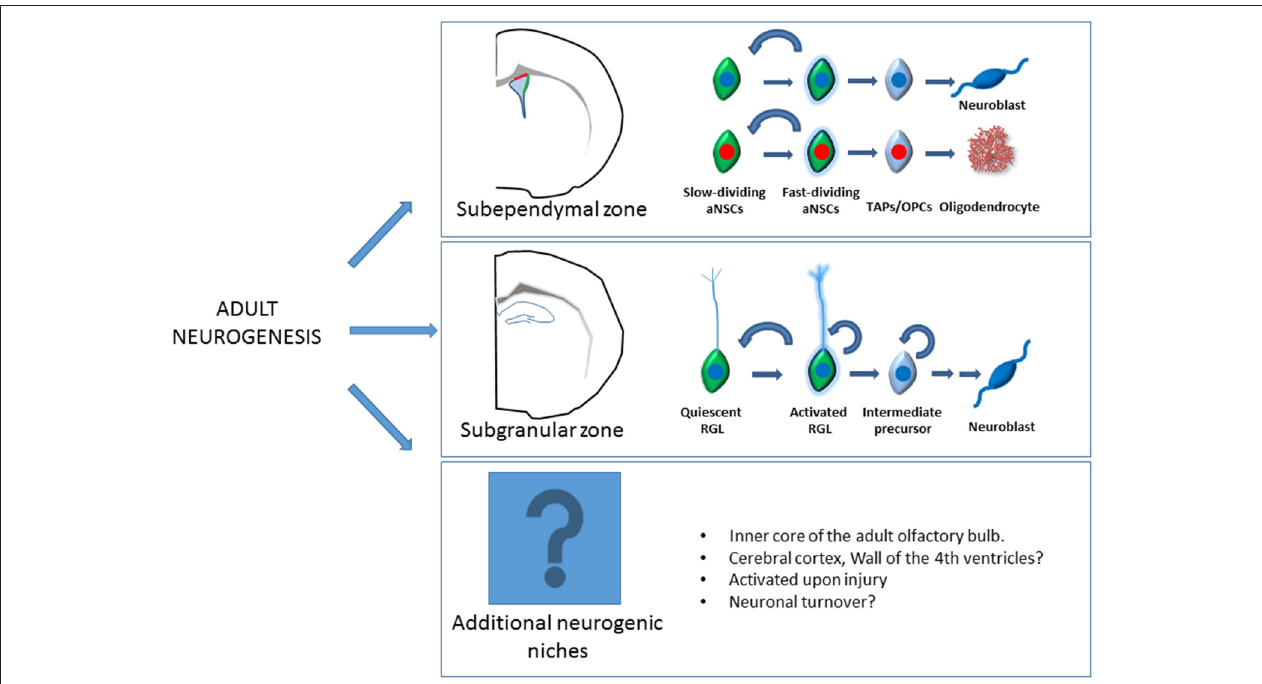
FIGURE 1 | Schematic representation of the adult neurogenesis. Here there are depicted the two main adult neurogenic niches, the subependymal zone in the lateral wall of the lateral ventricle and the subgranular zone in the hippocampus. Live imaging experiments have shown than within the SEZ, neurogenic, and oligodendrogliogenic lineage follows a similar pattern of lineage progression but constitutes independent lineages. Slow dividing astroglia (quiescent type B cells) give rise to fast dividing astroglia (activated type B cells) that subsequently generates Transit amplifying progenitors (TAPs) and finally neuroblast or oligodendrocytes. In the SGZ, quiescent radial glia like (RGL) progenitors become activated giving rise to intermediate progenitors and neuroblast that undergoes a complex process of maturation. Additional neurogenic niches like the olfactory bulb or the cerebral cortex have also been reported. The existence of undiscovered neurogenic niches should not be discarded. Several regions of the adult brain reactivate “dormant” aNSCs through signaling pathways released upon injury. Likewise, contribution of these quiescent aNSCs to the periodical turnover of neural populations still remains to be